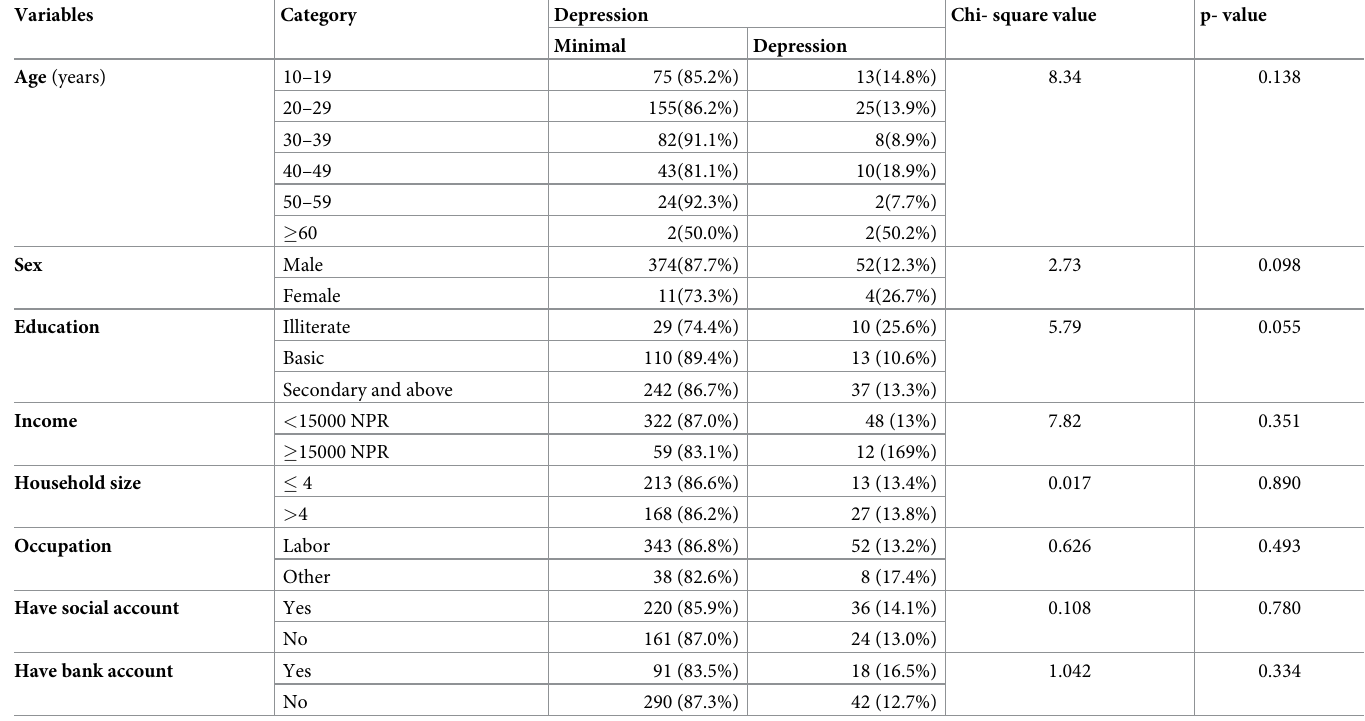
Table 3. Relationship between depression and independent